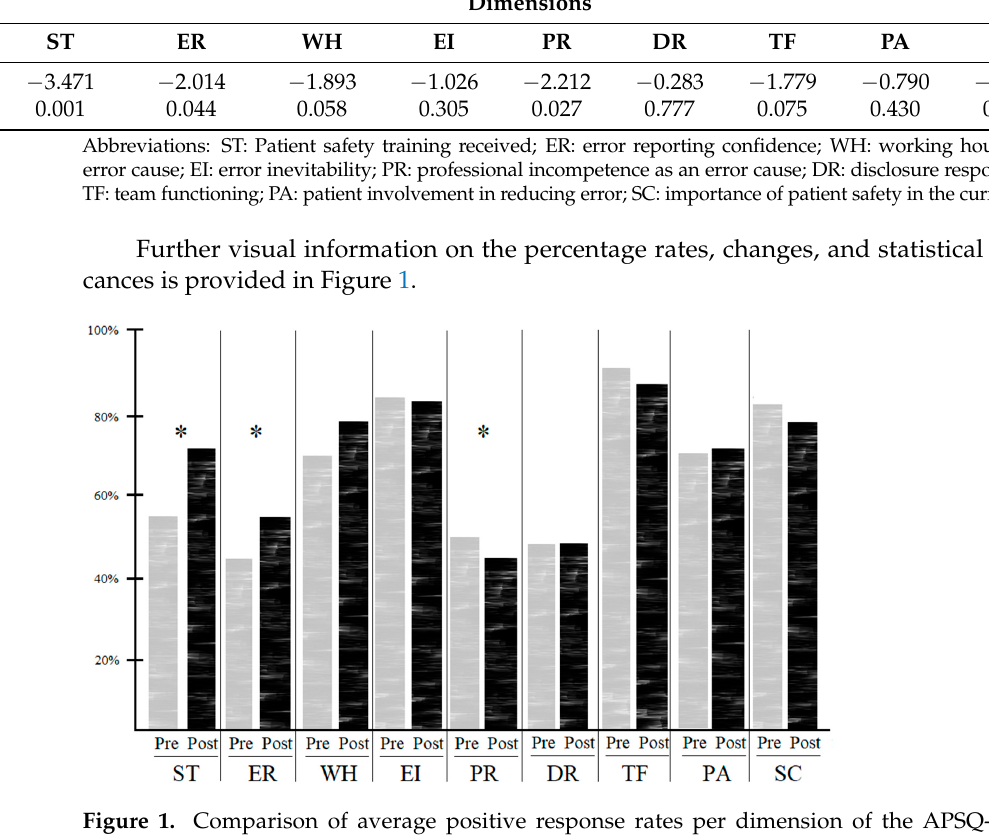
Table 3. Wilcoxon signed-rank test per paired APSQ-III dimensions (pre vs. post).